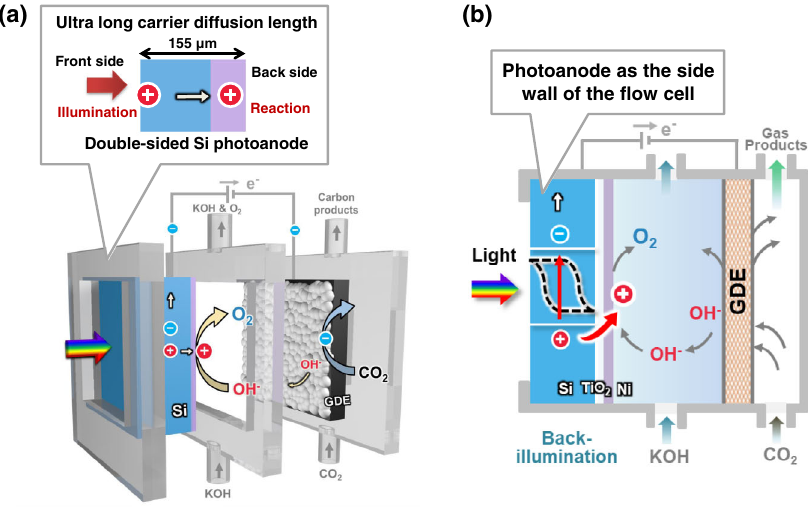
Fig.1|Siphotoelectrodepromoted fl owcell.a TheschematicoftheSiphotoanodecoupled fl owcellwiththegasdiffusionelectrodeforPECCO 2 RR. b Thecross-section of back-illuminated Si photoanode and the GDE cathode ( fi gure not to scale for clarity).